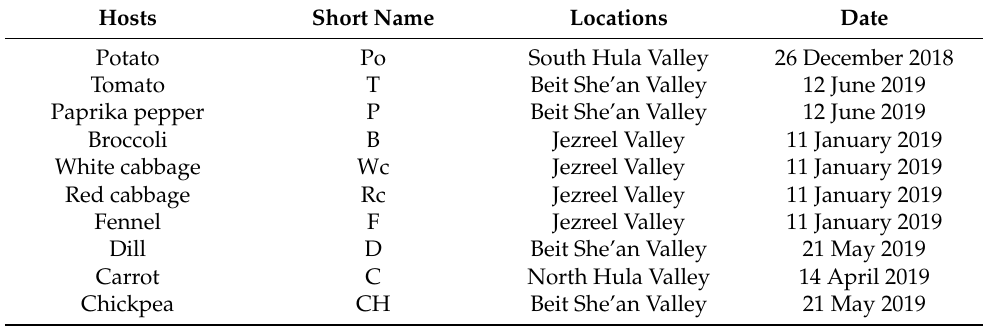
Table 1. The locations and dates of the parasites collected from the different hosts.